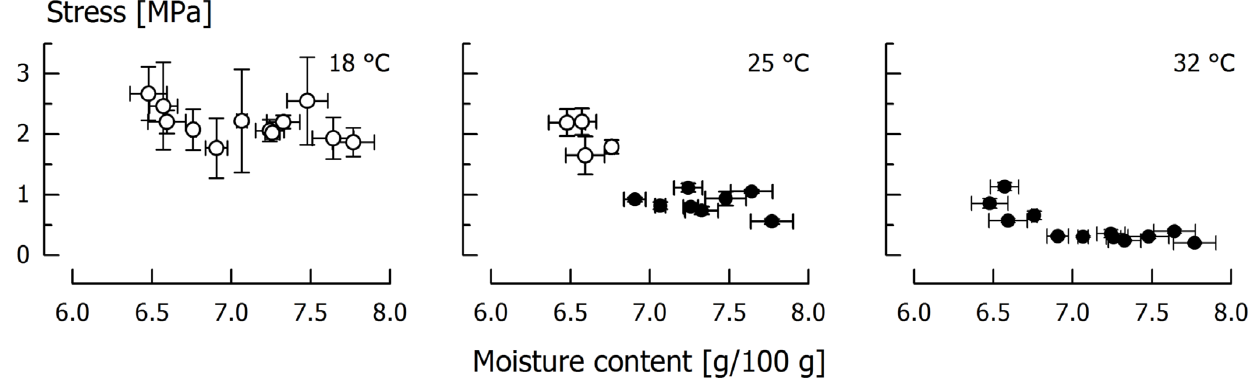
Figure 6. Fracture stress σ f (open circles) and tensile strength R m (closed circles) of caramel sub- jected to tensile testing at different temperature and at v = 1000 mm/min. Data are arithmetic means ± standard deviation for σ or R ( n = 3), and moisture ( n = 3).